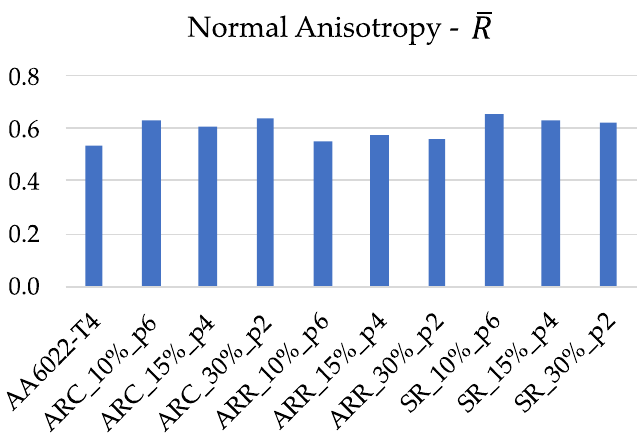
Figure 10. Lankford coefficient evolution with the rolling conditions.